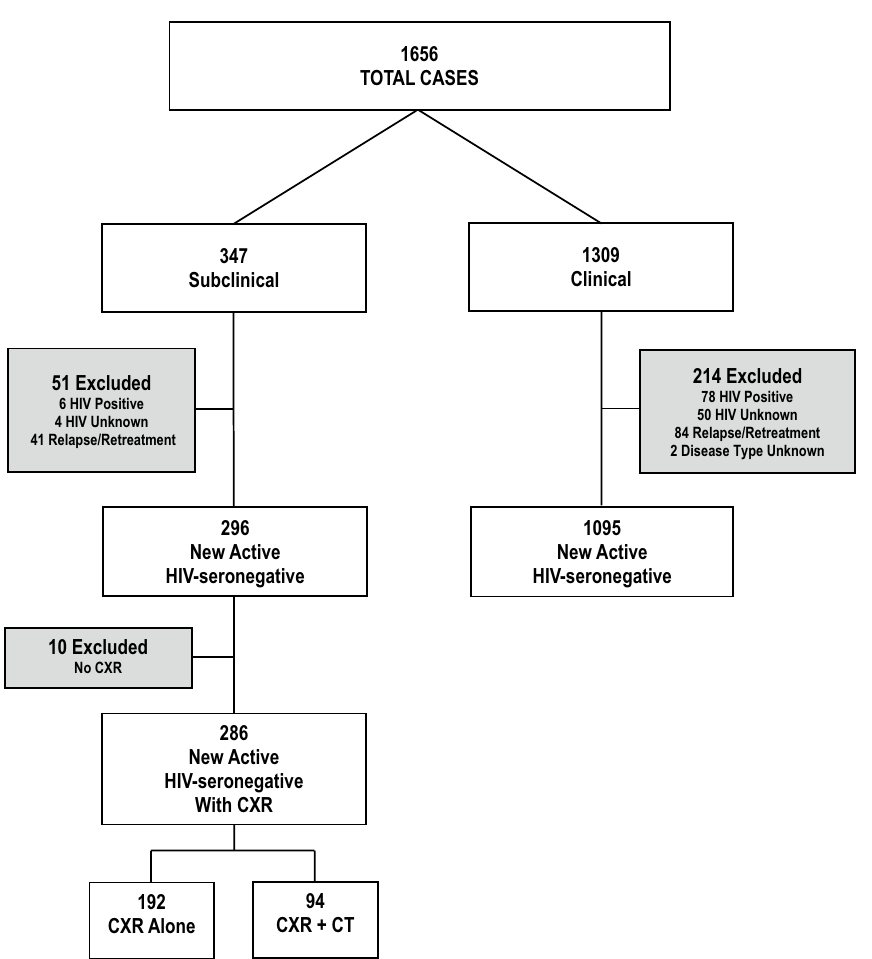
Figure 1. Adult culture-positive pulmonary tuberculosis patients in the Province of Alberta, Canada, 2005– 2020. Chest radiographs were performed in all but 10 of the HIV-seronegative, new active subclinical patients and all 41 of the HIV-seronegative relapse/retreatment subclinical PTB patients. CT scans were performed in 94 of the 286 HIV-seronegative new active subclinical PTB patients with chest radiographs and 4 of the 41 HIV- seronegative relapse/retreatment subclinical PTB patients with chest radiographs. This figure is an adaptation and extension of a previously reported figure. (see reference